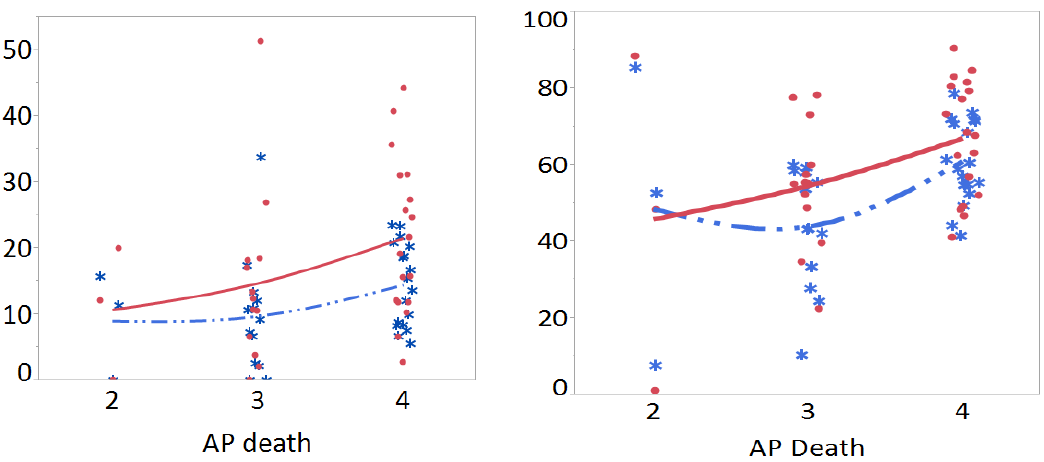
Figure 3. Nonlinear fit on percentage of MTHFR 677 TT ( left ) and MTHFR 677 TT + CT ( right ) polymorphisms for control (blue line) and congenital heart disease (red line) groups in association with death from air pollution for children. Note. AP death: Death rates from air pollution, Levels per million: 2: <100 (India, Mexico, and Brazil), 3: 100–250 (Germany, US, Iran, Egypt), 4: >250 (Portugal, Netherlands, China, Taiwan, Turkey).